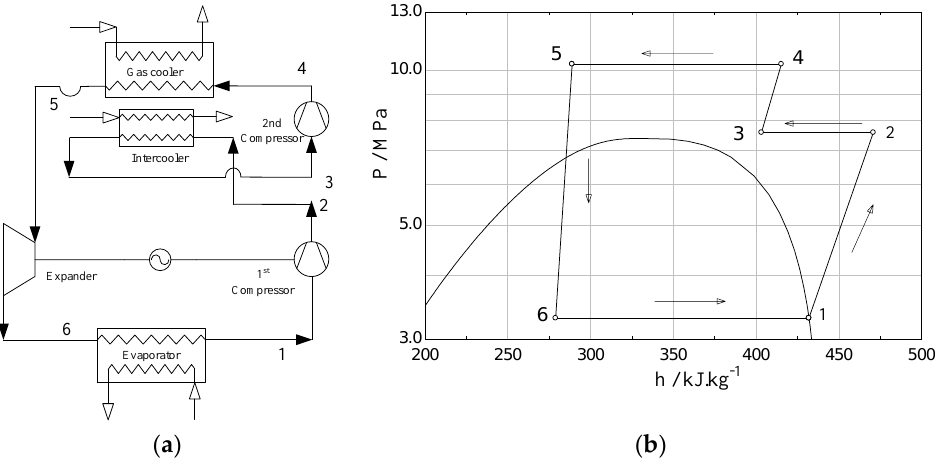
Figure 3. Schematic of TEADFC cycle and the corresponding P-h diagram. ( a ) Schematic diagram; ( b ) P-h diagram.